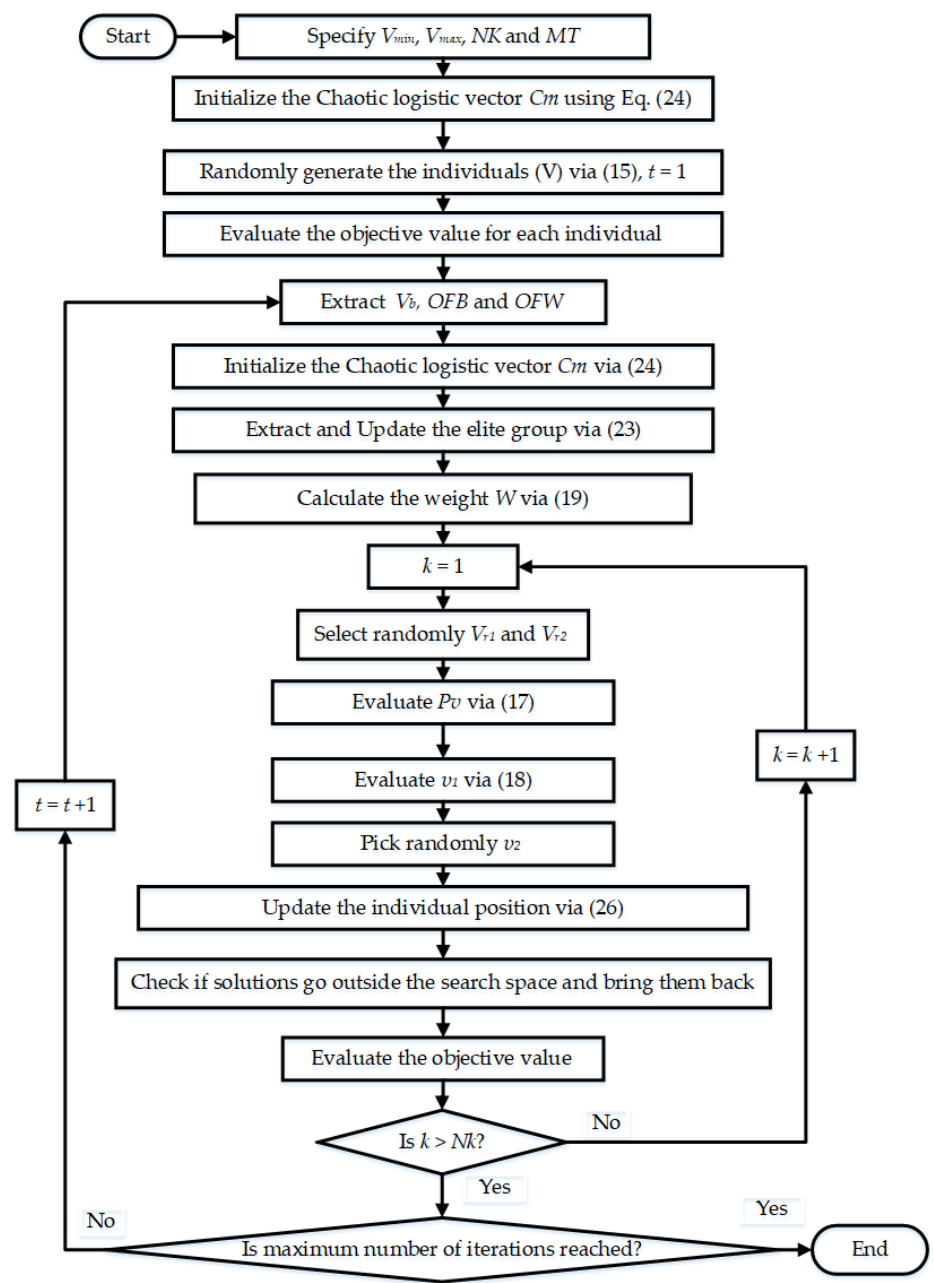
Figure 3. Proposed ESMOA fl owchart.